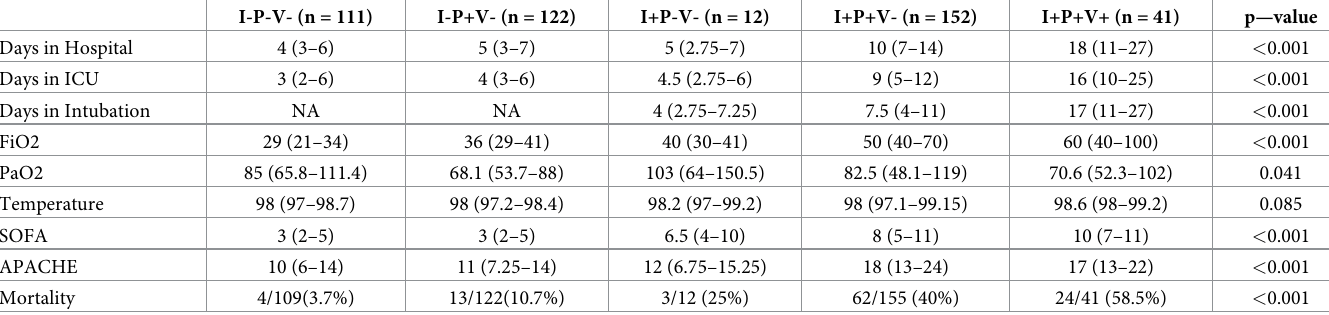
Table 3. Kruskal-Wallis rank sum test for the variables associated with different categories.